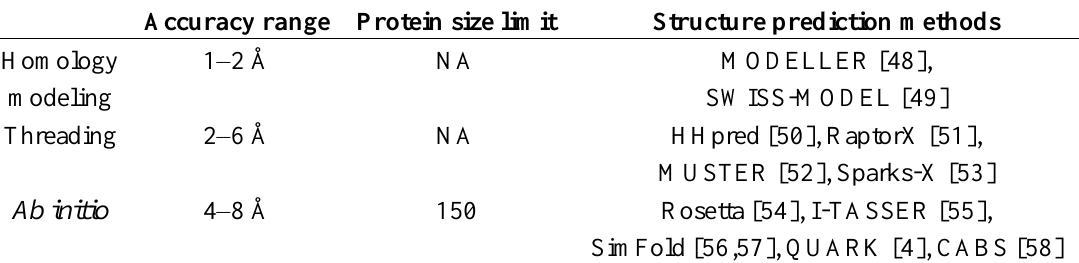
Table 2. Structure prediction methods and their